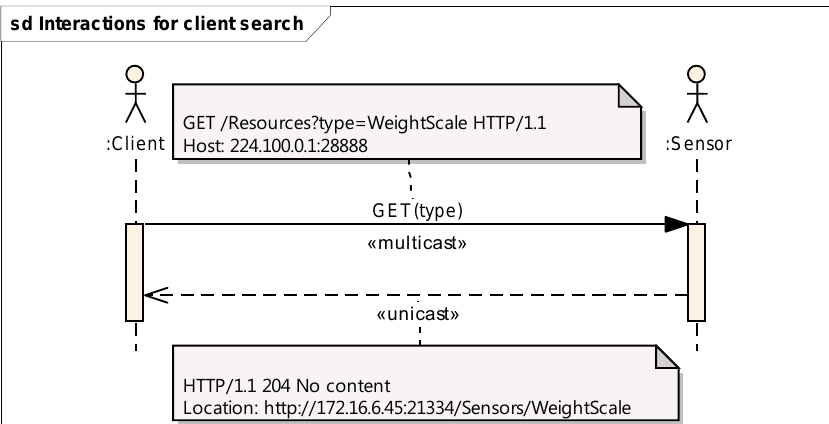
Figure 3. Sequence diagram for client